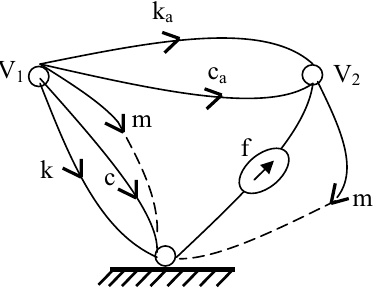
Fig. 2. Linear graph of mass–spring–damper